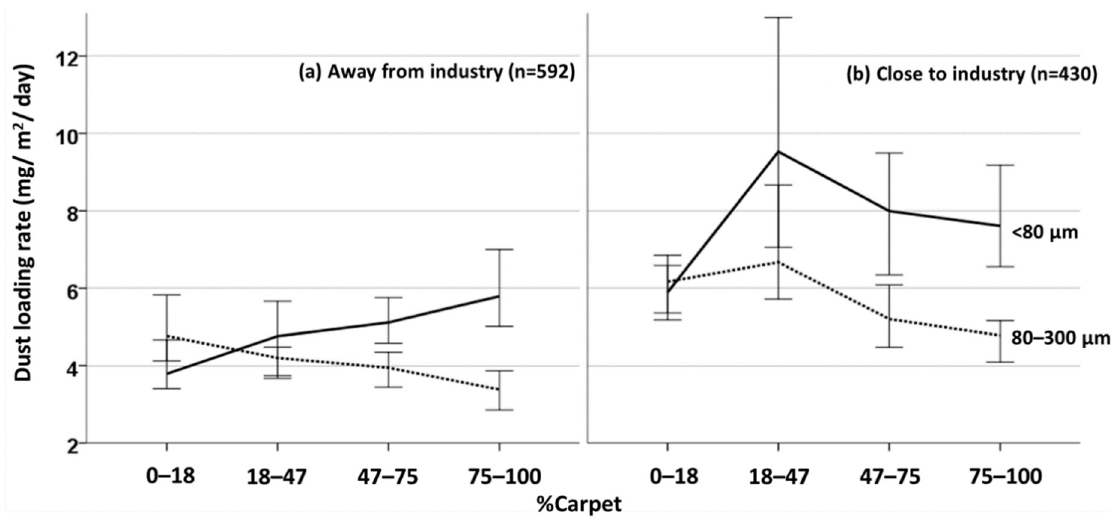
Figure 2. Influence of carpets on dust loading rates (mg/m 2 /day) in Canadian House Dust Study homes, located ( a ) more than 2 km from any industry and ( b ) within 2 km radius of any industry. Graphs show median values for two size fractions (<80 µm and 80–300 µm); error bars (75% CI) display variability of dust loading within each quartile. Details in SI-5.